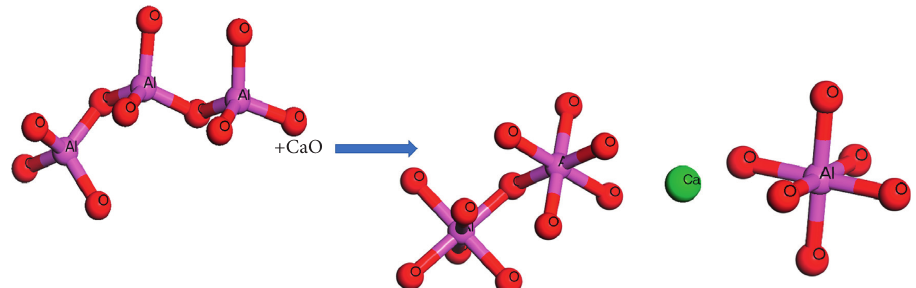
Figure 10: Schematic diagram for changes in the network.